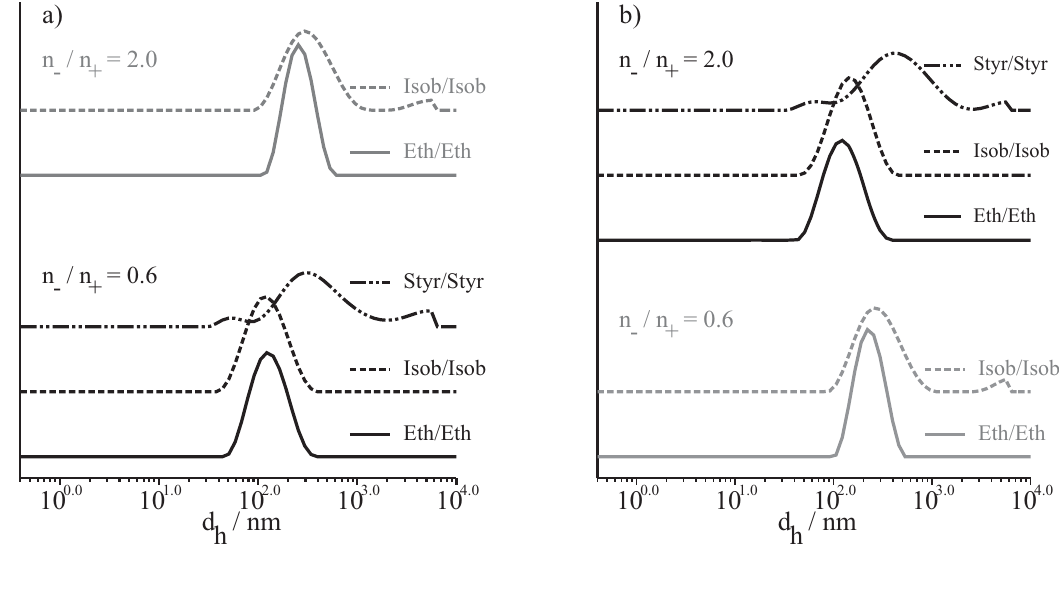
Figure 4. Particle size distributions of PECs with selected n procedure a and b. ( a ) PC is starting solution; ( b ) PA is